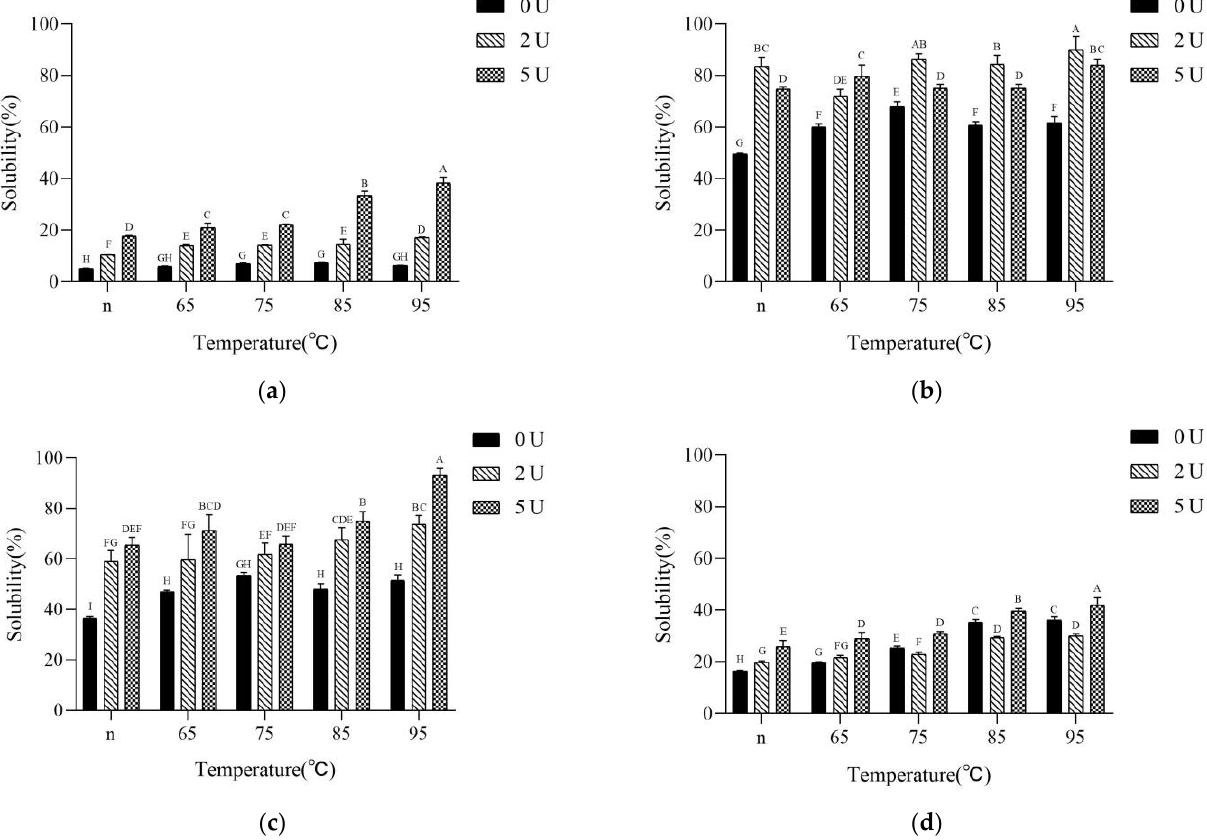
Figure 6. Solubility of SPI gels in different solvents. ( a ): 50 mM sodium phosphate (pH 7.0); ( b ): consisted of (a) and 8 M urea; ( c ): consisted of (a) and 0.5% SDS; ( d ): consisted of (a) and 0.25% βME. Different capital letters indicate significant differences ( p < 0.05).